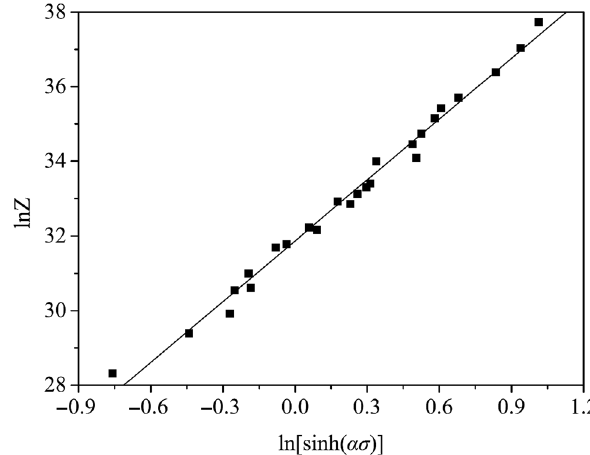
Figure 9: Relationship between ln Z and ln[sinh( ασ